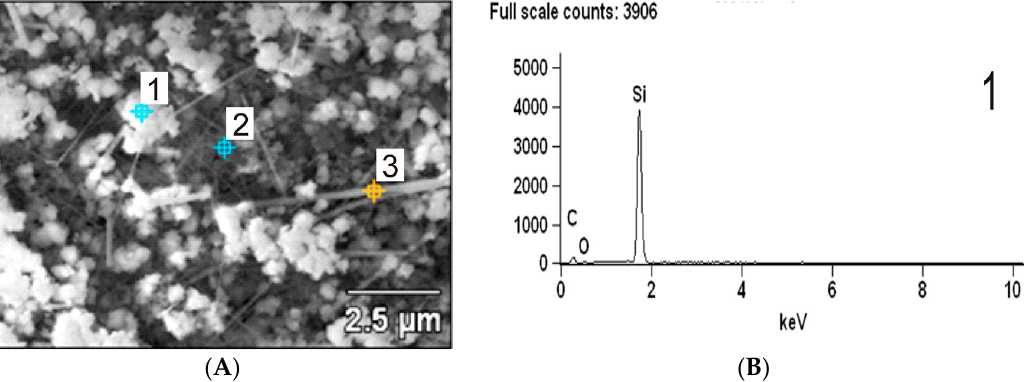
Figure 3. SEM/EDS analysis of the β -SiC nanocomposite obtained by thermal reduction of SiO 2 by graphitized carbon at 1550 °C for 1.5 h ( A ) SEM image, ( B ) EDS analysis of granular structure (point 1). EDS analysis of the (5) W x C- β -SiC sample revealed the presence of tungsten homogeneously distributed in the whiskers, but this element was absent from the granular structure (Figure 4A). Increased tungsten content was observed at the tips of the straight whiskers of the (5) W x C- β -SiC